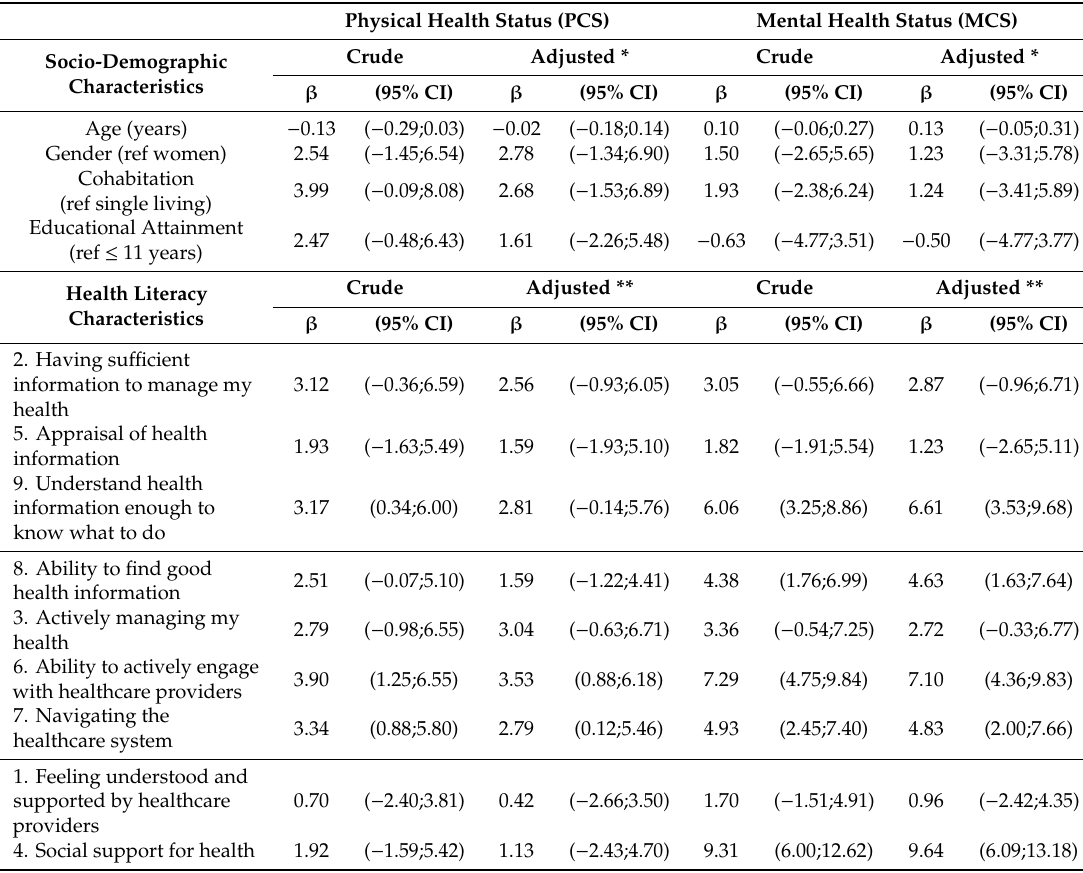
Table 4. Associations between socio-demographic and health literacy measures and health-related quality of